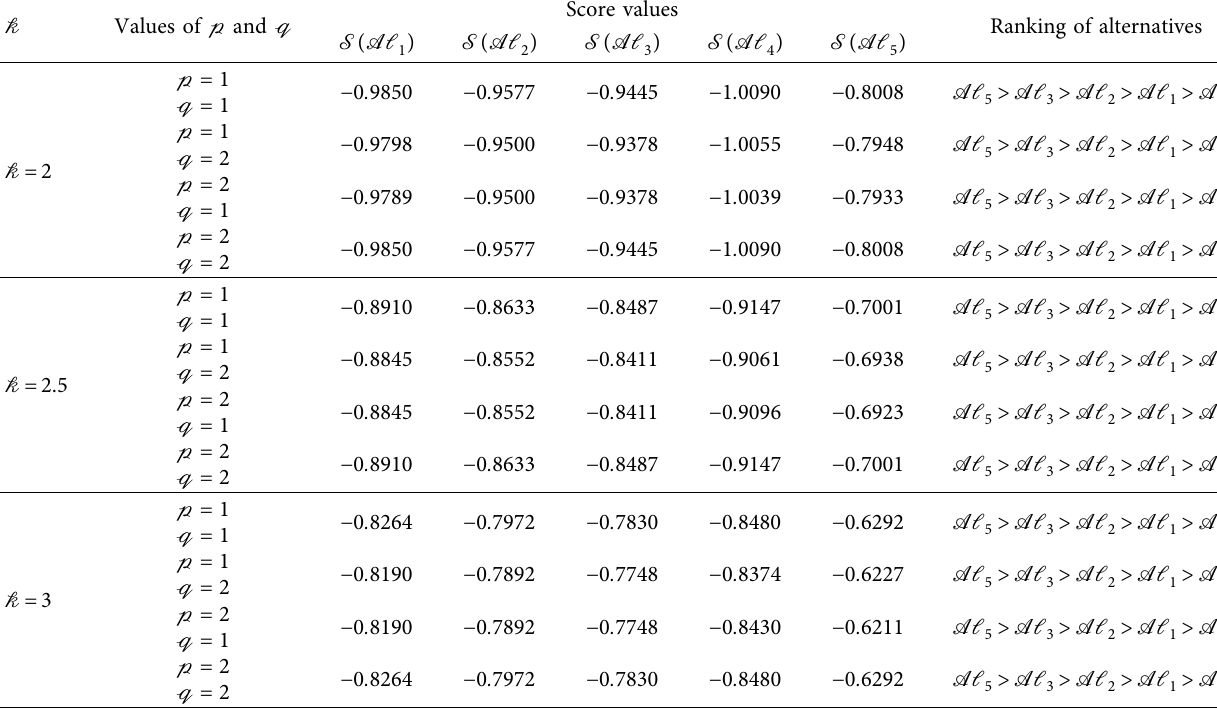
Table 6: Ranking of alternatives for different parameters by using the CIFDWBM operator.